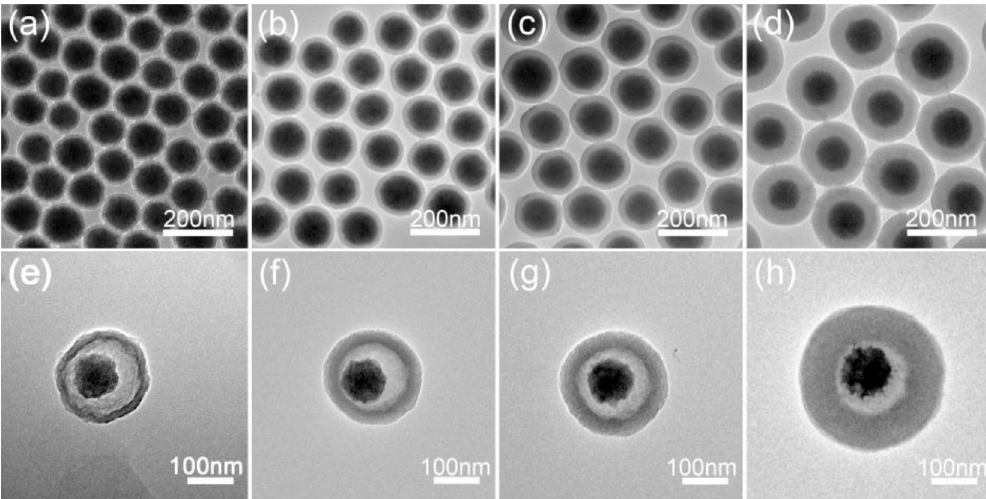
Figure 2. TEM images Fe 2 O 3 @SiO 2 microspheres with different SiO 2 shell thicknesses: ( a ) 15 nm; ( b ) 35 nm; ( c ) 50 nm; and ( d ) 80 nm; and ( e – h ) their corresponding TEM images of rattle-type Fe 3 O 4 @SiO 2 hollow microspheres [83].